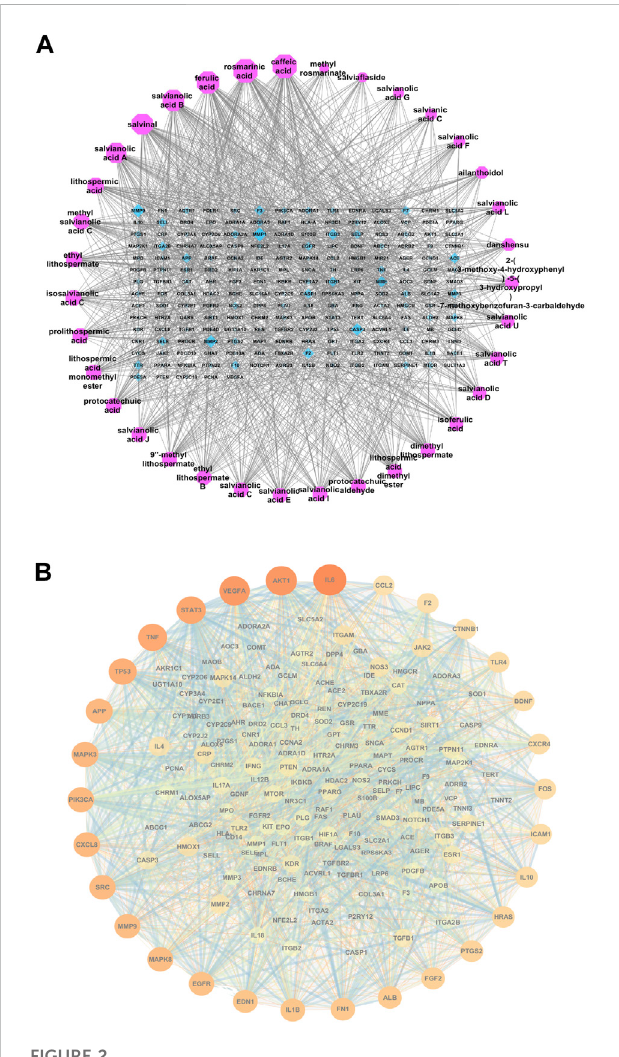
FIGURE 2 Phenolic acids — core target network (A) and top 30 targets in PPI network (B)